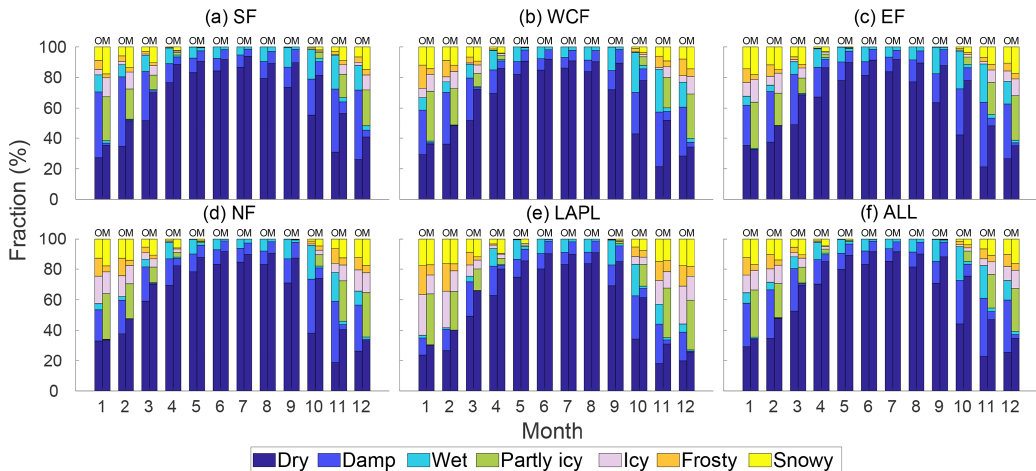
Figure 12. Observed (O) and modeled (M) fractions of road surface classes (e.g. dry, wet, or icy) within each month in 2002–2014 in (a) Southern Finland (SF), (b) Western and Central Finland (WCF), (c) Eastern Finland (EF), (d) Northern Finland (NF), (e) Lapland (LAPL), and (f) the averages for whole of Finland (ALL). The definitions of road surface classes differ slightly for the observations and model (e.g. the partly icy class is included only in the